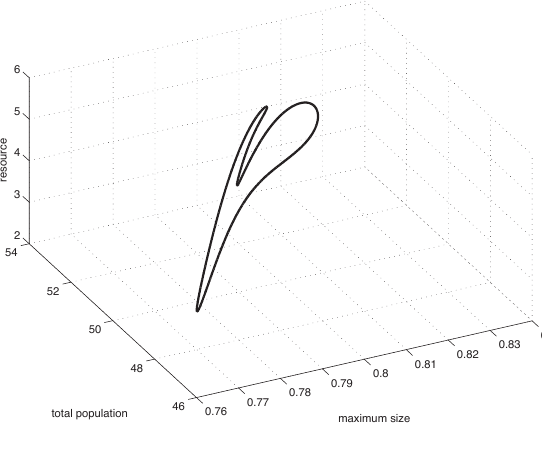
Fig. 2. Limit cycle appearing in the case of a bounded unstable steady